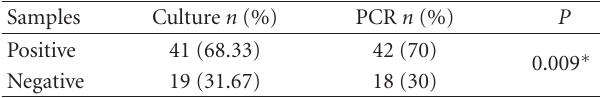
Table 4: Comparison of PCR and culture methods for detection of mycobacterial